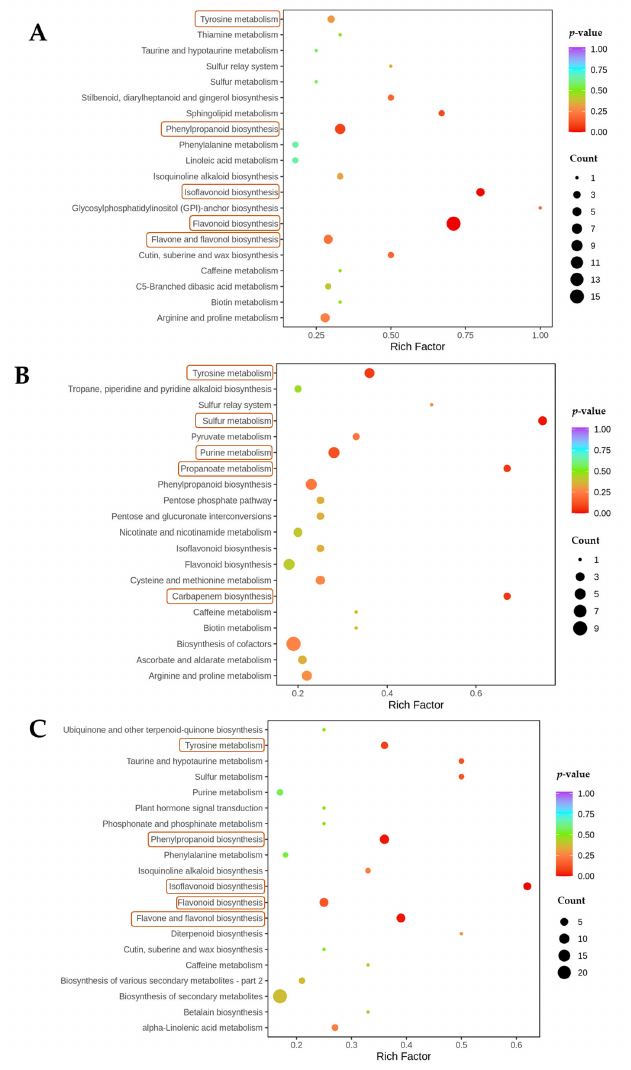
Figure 4. Statistics of metabolomic KEGG enrichment in ( A ) GR, ( B ) BR+3, and ( C ) BR+9. The horizontal coordinate indicates the rich factor of each pathway, the vertical coordinate is the name of the pathway, the color of the dot reflects the p ‐ value size, and the redder the color, the more significant the enrichment. The size of the dots represents the number of differential metabolites enriched. Enrichment is significant in the pathway labeled yellow.